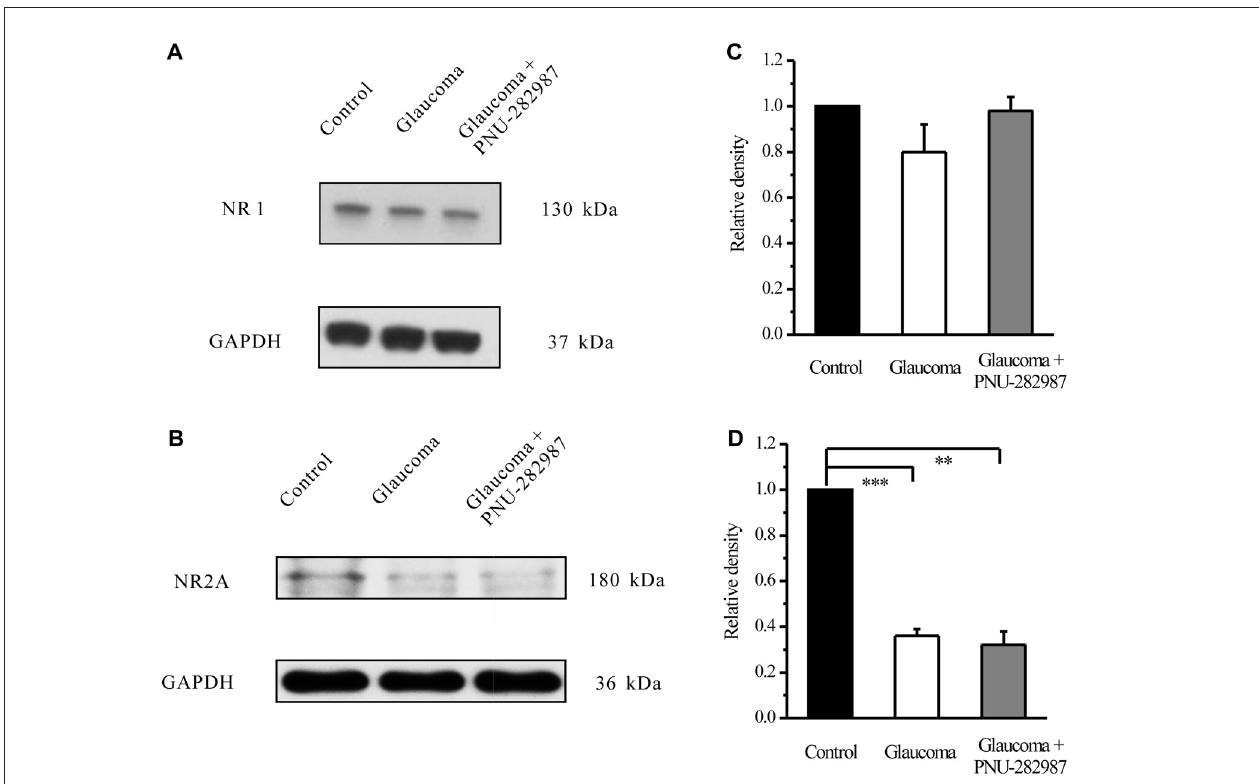
FIGURE 8 | Effect of PNU-282987 on NR1/NR2A expression levels in the retina. (A) Immunoblot analysis of NR1 in the retinas of control and glaucomatous rats before and after PNU-282987 injection. (B) Quantitative analysis of NR1 expression. (C) Immunoblot analysis of NR2A in the normal, glaucoma and glaucoma + PNU-282987 conditions. (D) Quantitative analysis of NR2A expression. The data are presented as the mean ± standard error of four samples for each experiment. ∗∗ p < 0.01, ∗∗∗ p < 0.001 (one-way analysis of variance). Full-length blots are presented in Supplementary Figure